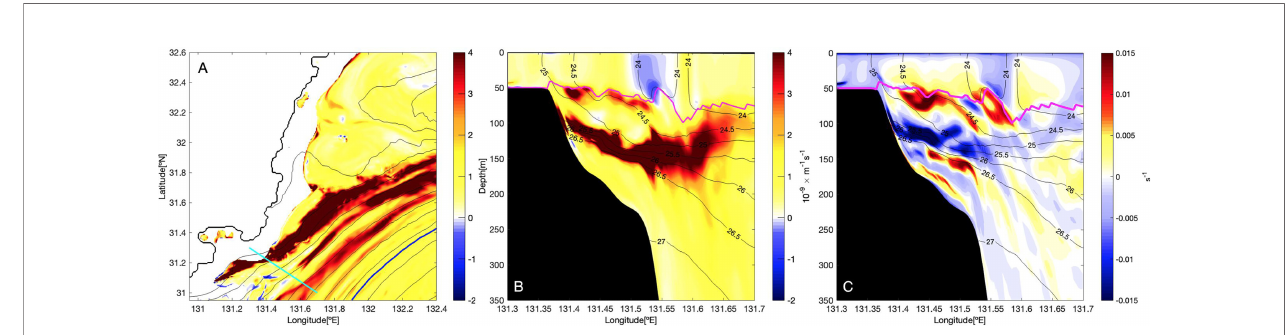
FIGURE 6 | Potential vorticity and vertical shear from the simulation on December 20 th at hour 08:00 for (A) plane view of potential vorticity (2) interpolated at 100 m depth, vertical sections computed along the cyan line in (A) for (B) potential vorticity (m -1 s -1 ) and (C) zonal shear (s -1 ). Blue contour in (A) represents the model Kuroshio axis at SSH = 0.2 m, and magenta line in (B, C) is